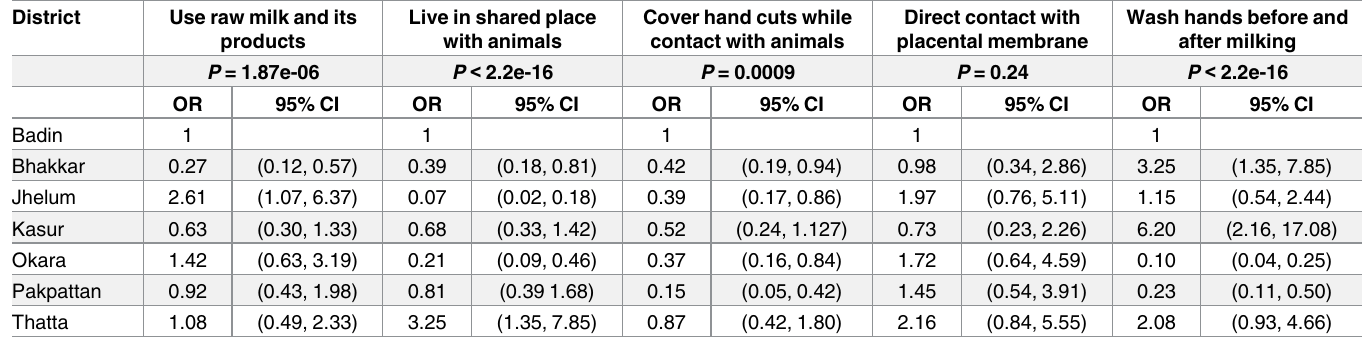
Table 9. Summaryof the univariable models for household practicesshowing the effect of District. Columns of the table refer to specific practices (outcome variables) and rows refer to particular districts. Shown are the odds ratio (OR) and 95% confidenceinterval (95% CI) for the OR, relative to the refer- ence district Badin in the Sindh province(OR =